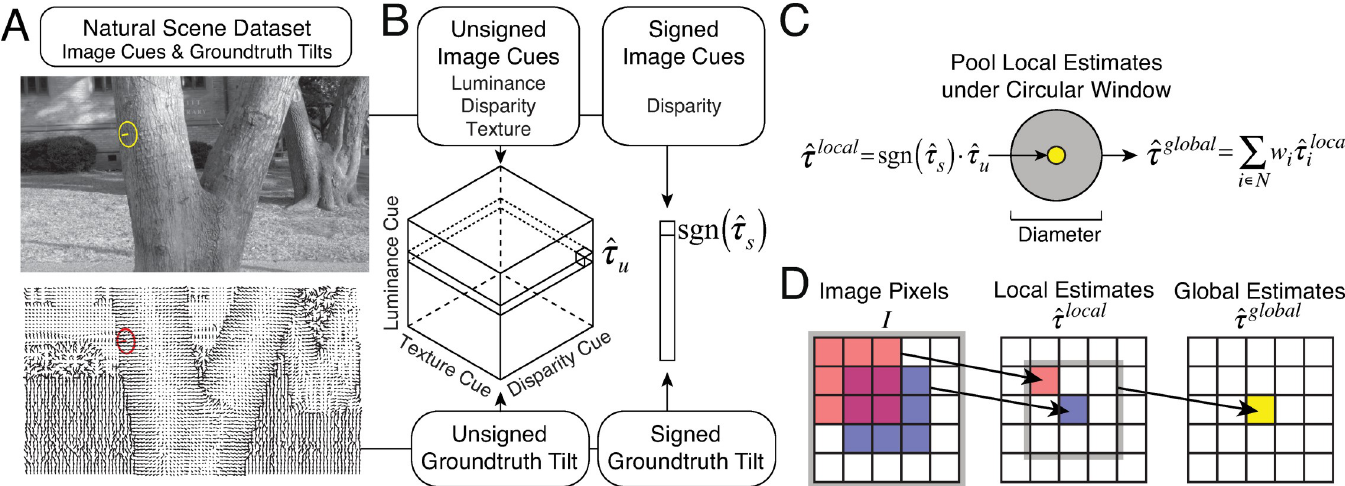
Fig 4. Constructing local and global models of tilt estimation. A Image cues and groundtruth tilt in natural scenes. Image cues are derived directly from photographic stereo images (top). Groundtruth tilt at each pixel is computed directly from the range data (cf. Fig 2A). Here, groundtruth tilt is depicted with local surface normals instead of a colormap (cf. Fig 2B). B The local model estimates tilt based on local image cues. Local estimates are obtained via lookup tables that store conditional means (i.e., posterior means) given all possible combinations of three quantized unsigned image cue values (i.e., 64 3 unique cue combinations), and one quantized signed image cue value (i.e., 64 unique cue values), as computed from the natural image database. We have previously verified that quantizing the cue values is not a primary limiting factor on the performance of the model [16]. C Pooling local estimates in a spatial pooling region centered on a target location. D Each global estimate is obtained by pooling local estimates over a spatial neighborhood. Each local estimate is obtained by combining cues that are computed from multiple pixels in the image. Note that the area of the image that contributes to the global estimate is slightly larger than the purported area of the global pooling region, because each local estimate is computed from image gradients across an image region with non-zero spatial